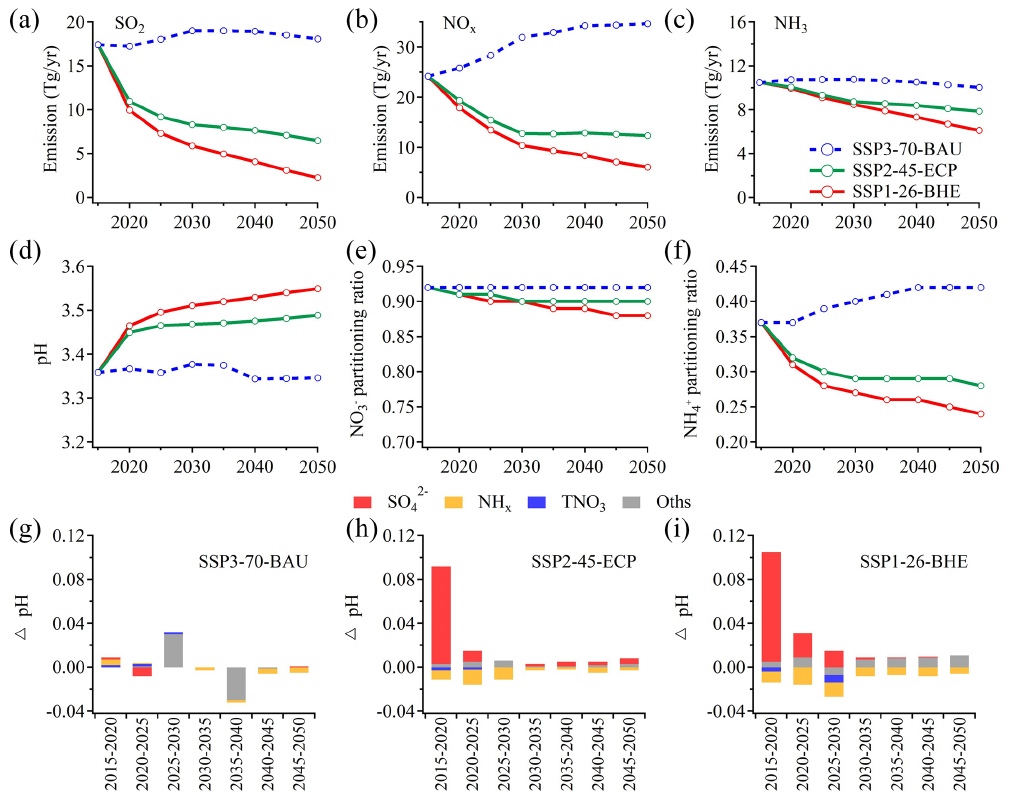
− + + HNO / (NO − partitioning (NO − partitioning 3 )) (e) and NH 3 3 3 4